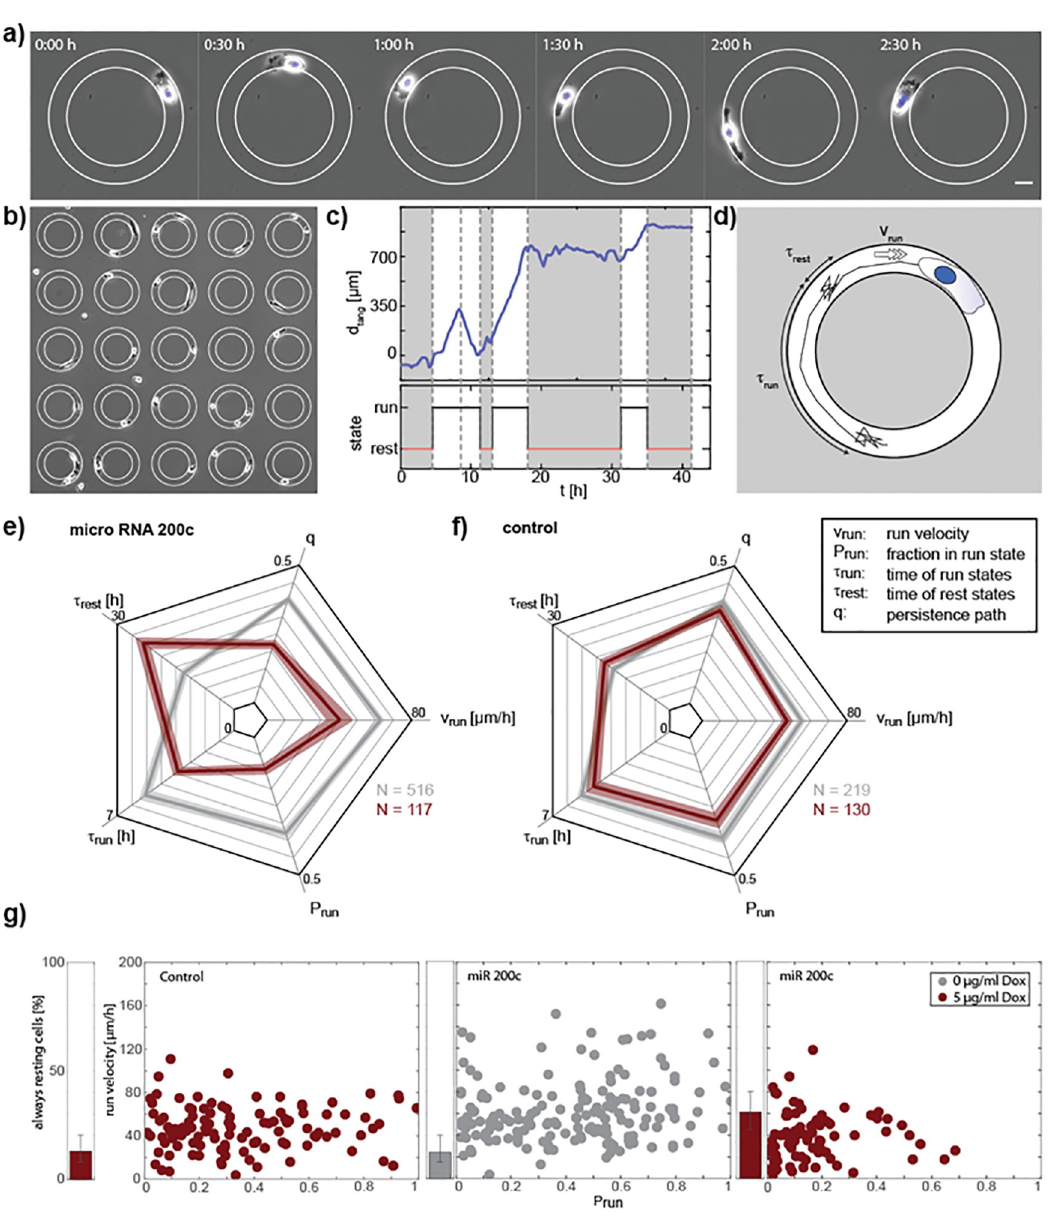
Fig 2. miR-200c induction decreases migration of MDA-MB-231 cells as shown in the 1D migration assay. (a) Phase contrast images of a MDA-MB 231 cell migrating on a ring shaped micro-lane. The ring is coated with fibronectin (edges marked in white) the surrounding is passivated with PEG. The scale bar is 20 μ m. (b) Array of ring shaped micro lanes. Only rings that are occupied by one single cell are evaluated. (ring diameter 150 μ m) (c) Angular position of one exemplary cell over time with classification into run and rest states. (d) Drawing of a cell track. Cell motion can be separated in run states with ballistic motion and rest states with random motion. The characteristic duration of run and rest states τ run , τ rest as well as the velocity in the run state v run are evaluated. (e, f) Multi-parameter analysis of cell motility of cell populations. Motility of cells is measured 48h after induction with 5 μ g / ml doxycycline (red). For MDA-MB-231 TRPZ-200c cells (f) a clear reduction of cell motility can be seen in all of the 5 parameters compared to no induction (grey). For MDA-MB-231 TRPZ-Ctrl cells (h) no big effects on motility are observed with adding doxycycline. N is the number of cells analyzed. (g) Single cell analysis of P run and v rest for the data shown in e, f) where each dot represents a single cell. One cell population is spread over a large range of velocities and fraction of time in the run state. Induction of miR 200c is causing a shift to slower velocities and less time spent in the rest state. (error bars in g and h indicate standard errors exept for τ run , τ rest where it’s CI of 99% of the